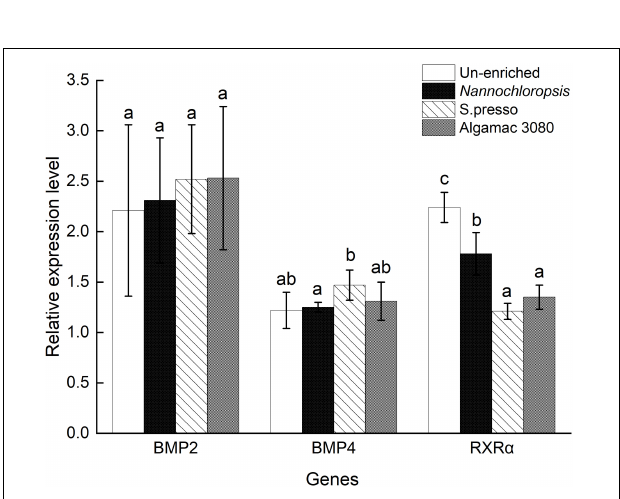
FIGURE 3 | Final survival rate of golden pompano larvae in four treatments.